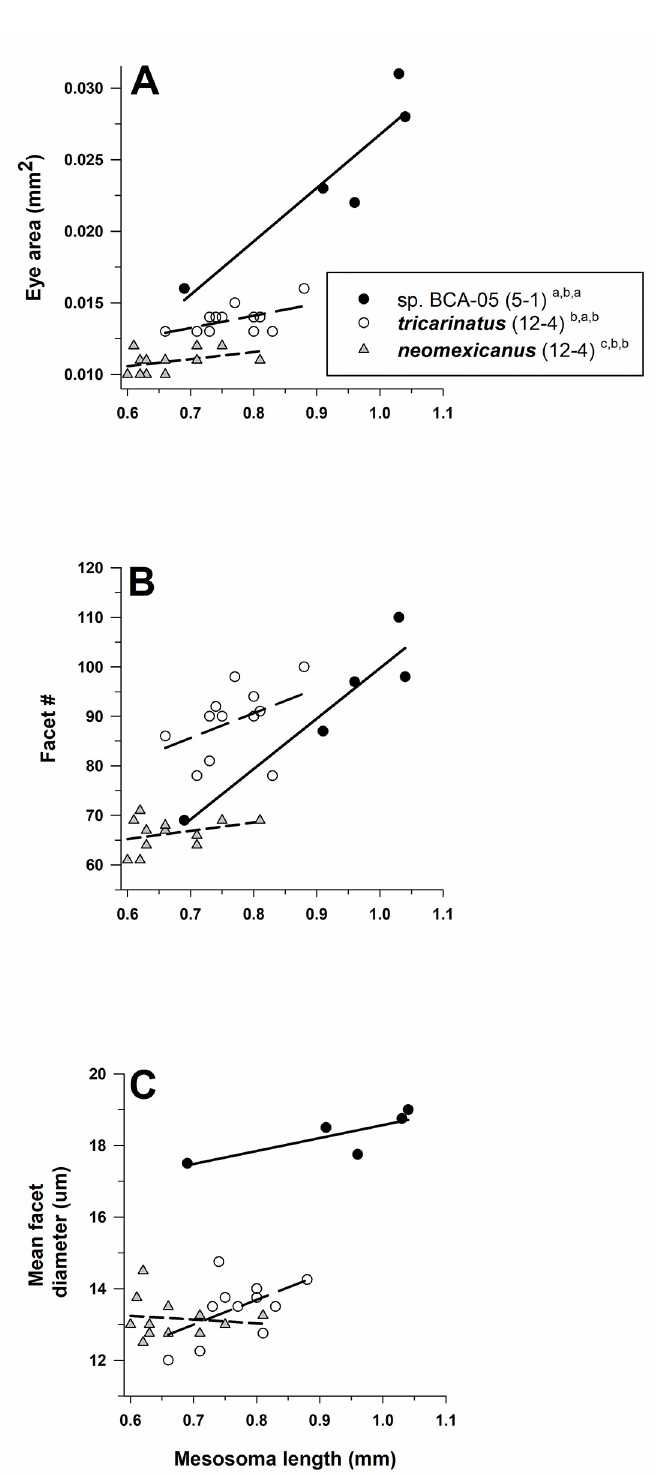
Fig 8. Eye area (mm 2 ) (A) , facet number (B) , and mean facet diameter ( D ) ( μ m) (C) for species of Temnothorax (subfamily Myrmicinae: tribe Crematogastrini). Temnothorax sp. BCA-5 is pale (open symbols and regular font), while T . neomexicanus and T . triacarinatus are dark (filled symbols and bold font) (see text). For each species, number of workers examined and number of colonies they were derived from is given in parentheses. Significant differences ( P < 0.05) among species are denoted after each species name by the letters a–c : a > b > c ; the three sets of letters